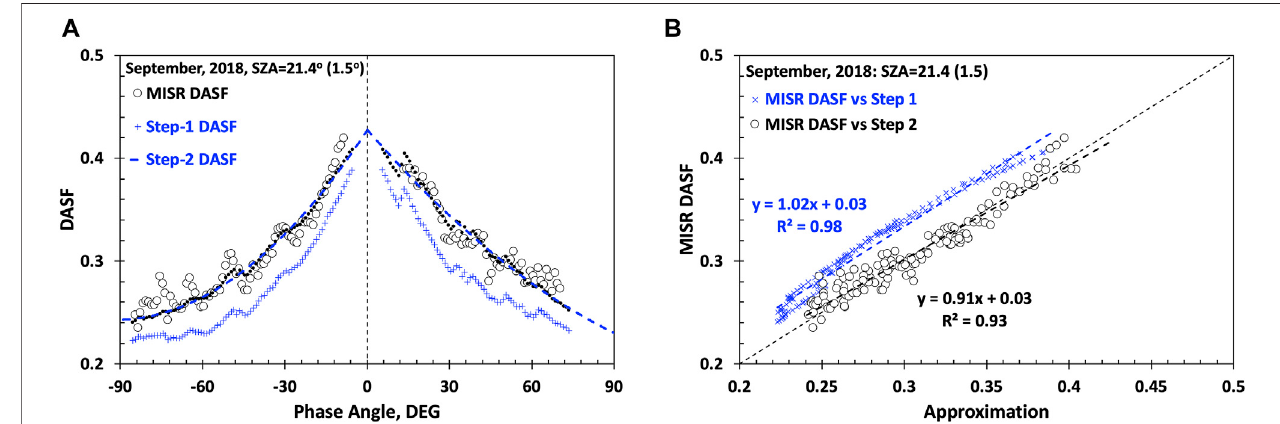
FIGURE 3 | (A) MISR DASF of region 2 (Congo forests) in September-2018 (hollow circles). Its step-1 and step-2 approximations are shown as crosses and dots, respectively. The dashed line is a polynomial fi t to the Step-2 approximation. (B) MISR DASF versus step-1 (crosses) and step-2 (circles) approximations. NRMSEs between MISR DASF and its Step 1 and Step 2 approximations are 12 and 4%, respectively. Mean SZA (std) (cid:2) 21.2 0 (1.5 0 ), h (cid:2) 0.8, LAI (cid:2) 5.6, L (cid:2) 7.15.